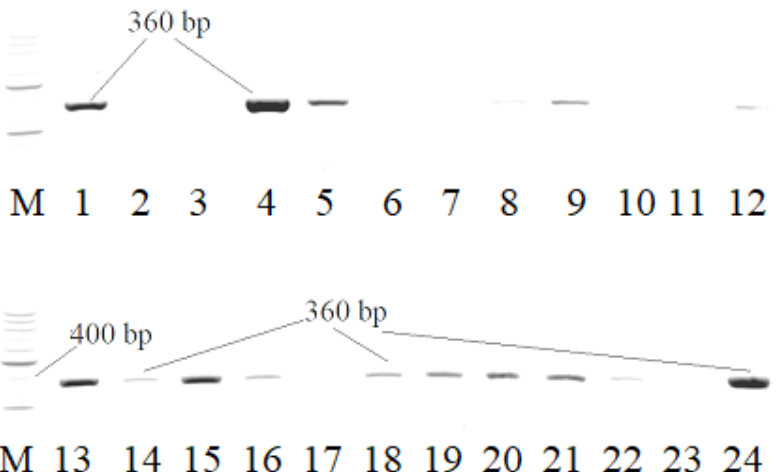
Figure 5. Detection of PSTVd strain VP87 at 60 dpi in potato cultivars: 1—Udacha, 2—Avrora,